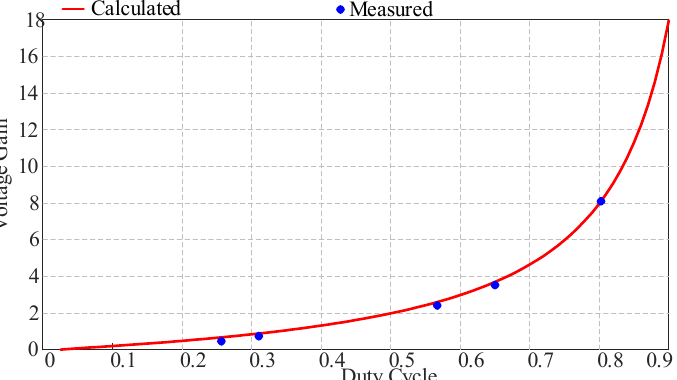
Figure 15. Calculated and measured converter voltage gain vs. duty cycle.